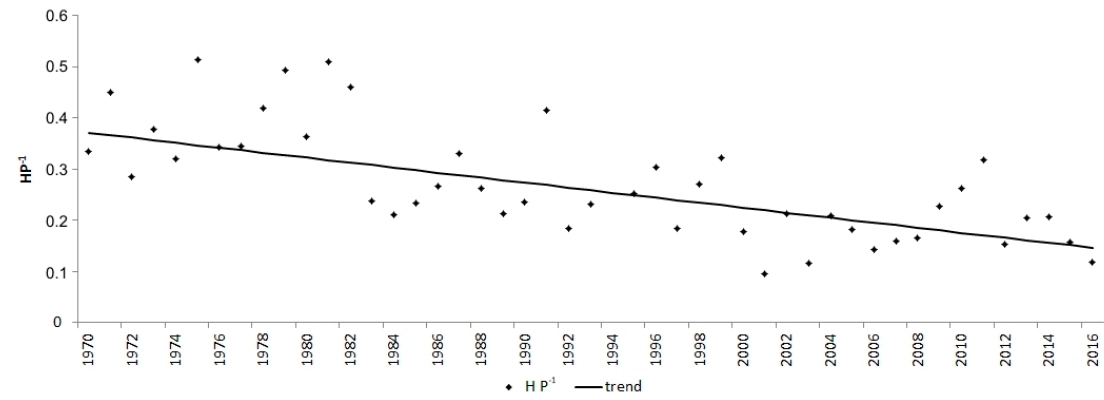
Figure 5. HP − 1 ratio from 1970 to 2019. (The equation for the trend line is presented in Table 1).